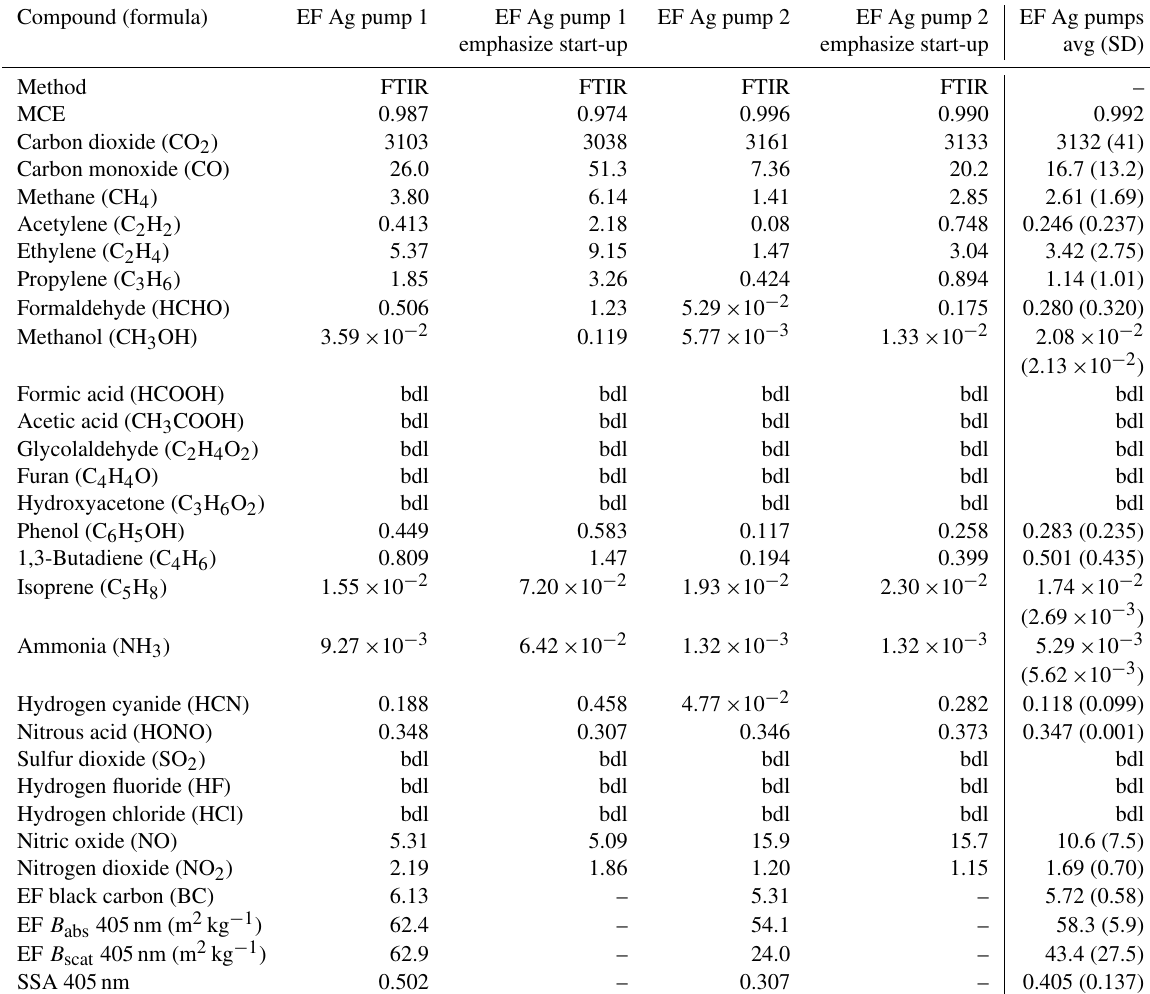
Table 2. Emission factors (gkg − 1 ) for agricultural diesel irrigation pumps including EFs weighting only start-up